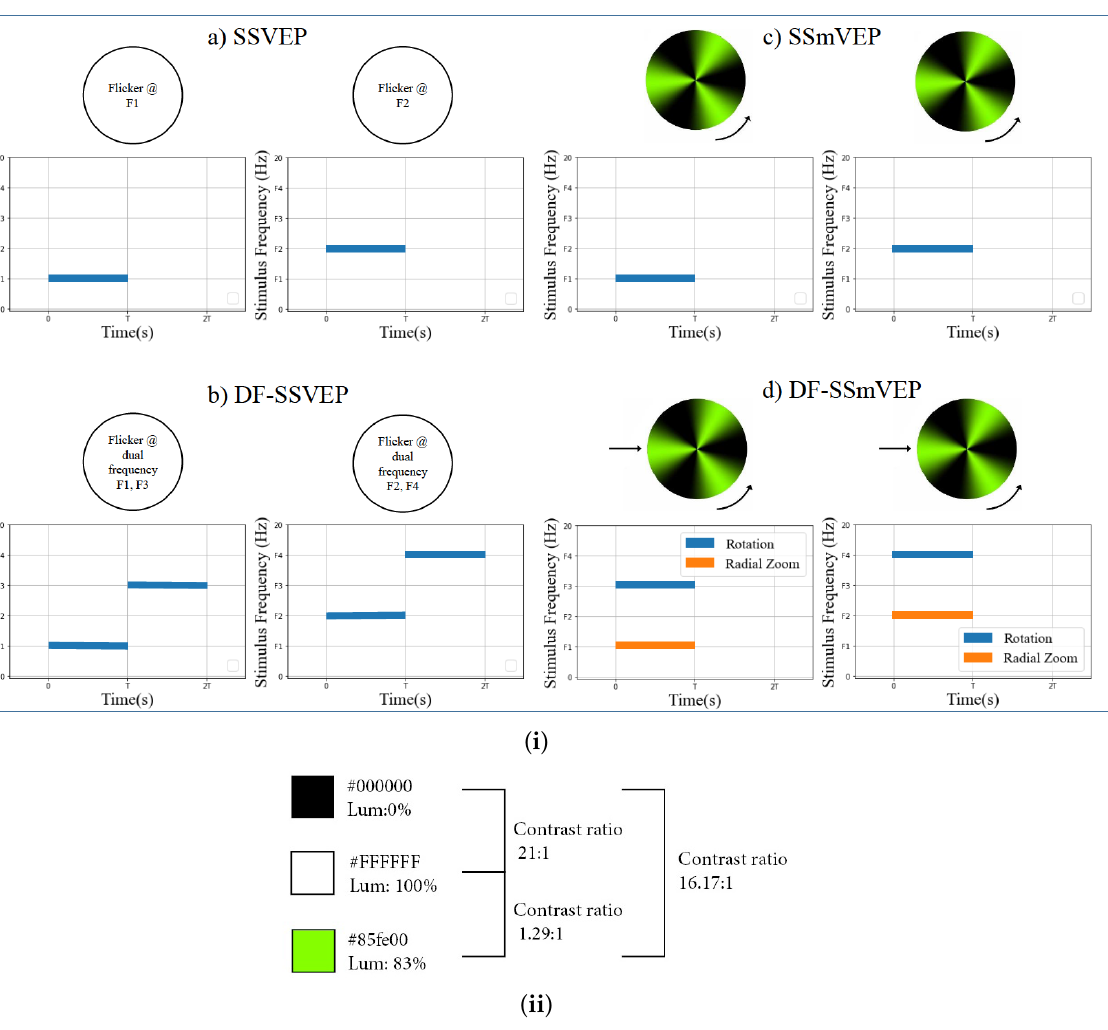
Figure 2. ( i ) Comparison between existing SSVEP frequency modulation schemes ( a , b ) with SSmVEP ( c ), and the proposed DF-SSmVEP ( d ). ( ii ) Luminance contrast ratio of the colors used in the designed